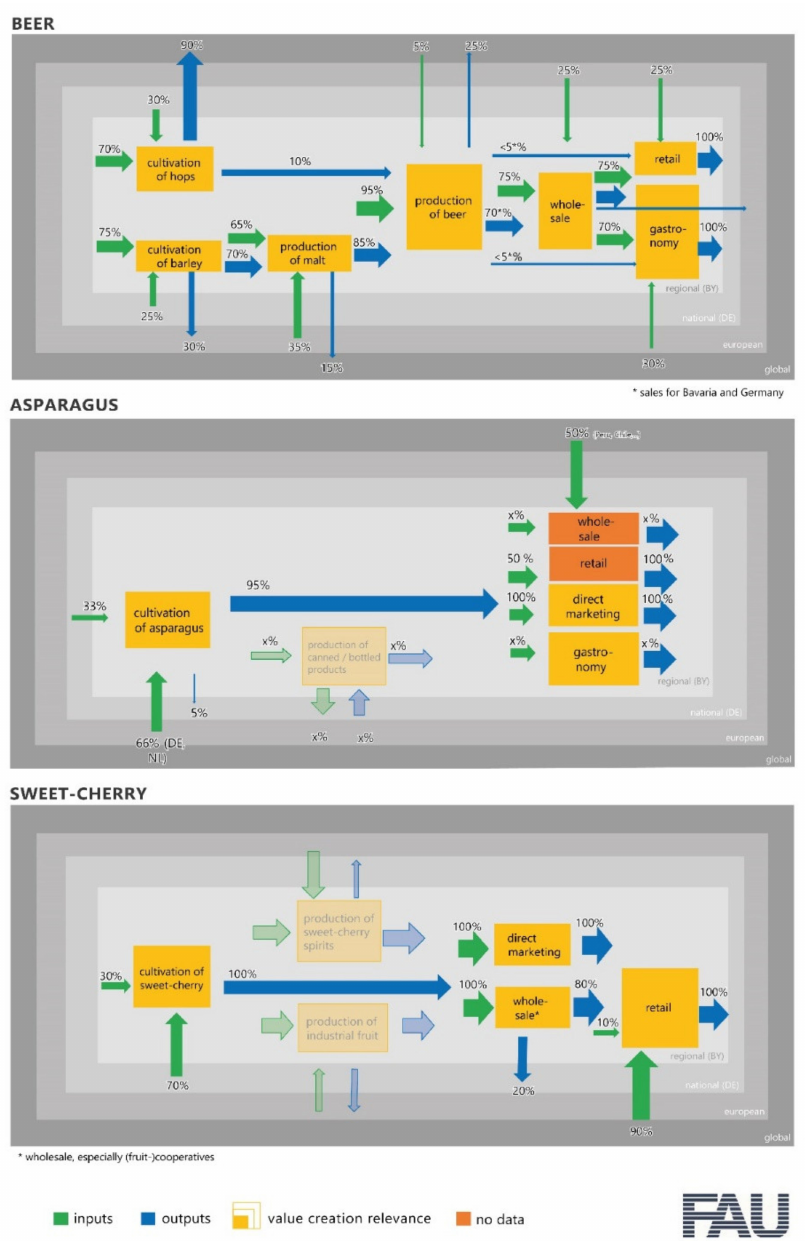
Figure 2. Value creation mappings for beer, asparagus and sweet cherry (NB the size of the yellow value creation signatures differs between the